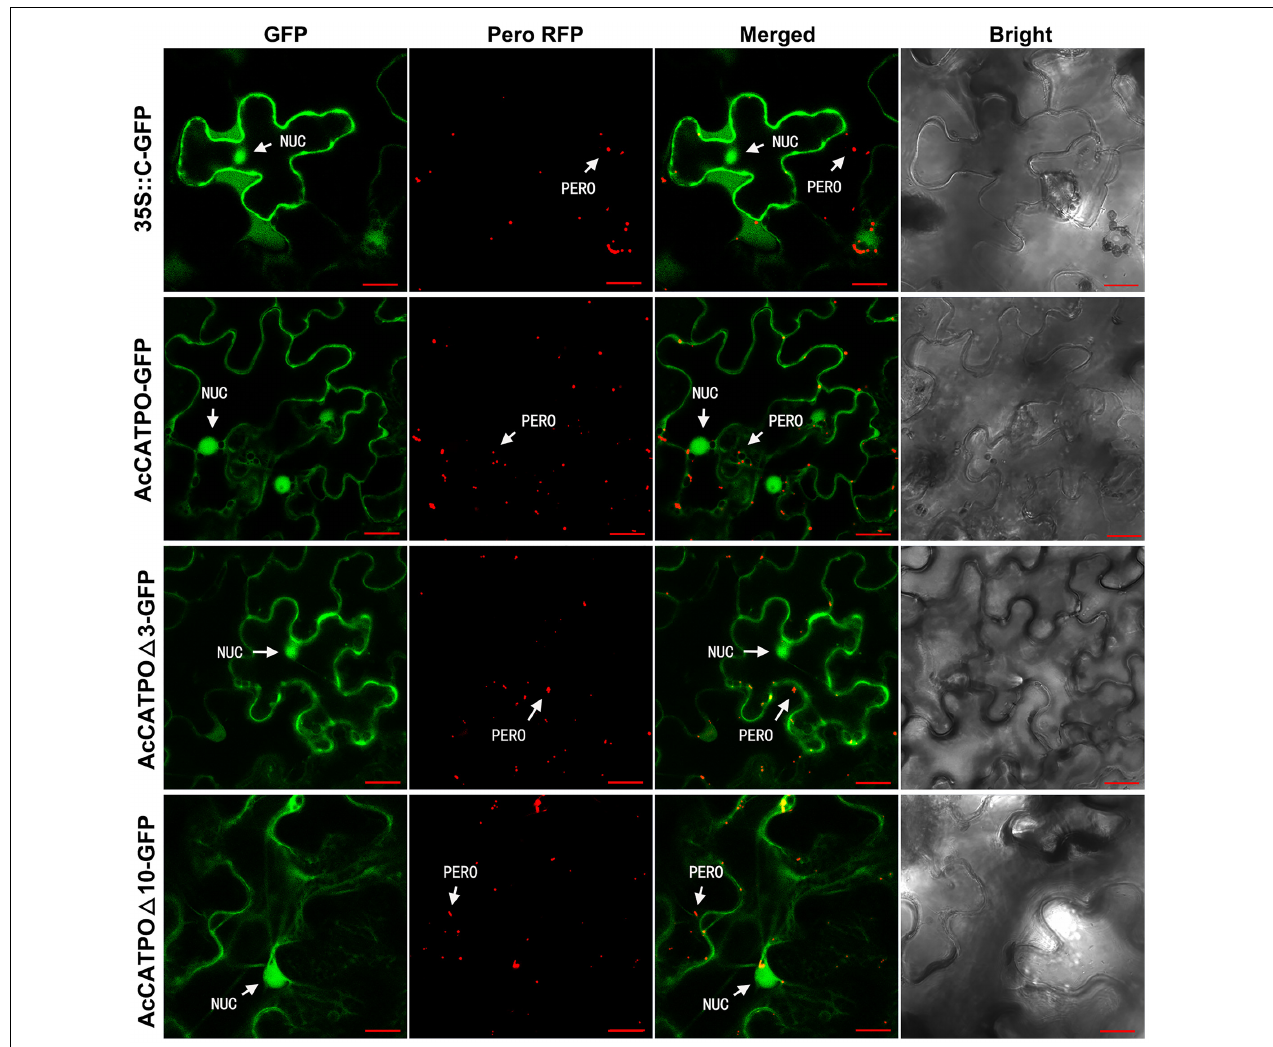
FIGURE 3 | Confocal fluorescence scanning of AcCATPO and AcCATPO (cid:49) with C-terminal GFP tag (Gene-GFP). See Figure 2 legend for detail, except AcCATPO-GFP, AcCATPO (cid:49) 3-GFP and AcCATPO (cid:49) 10-GFP, GFP tagged at the C-terminus of the